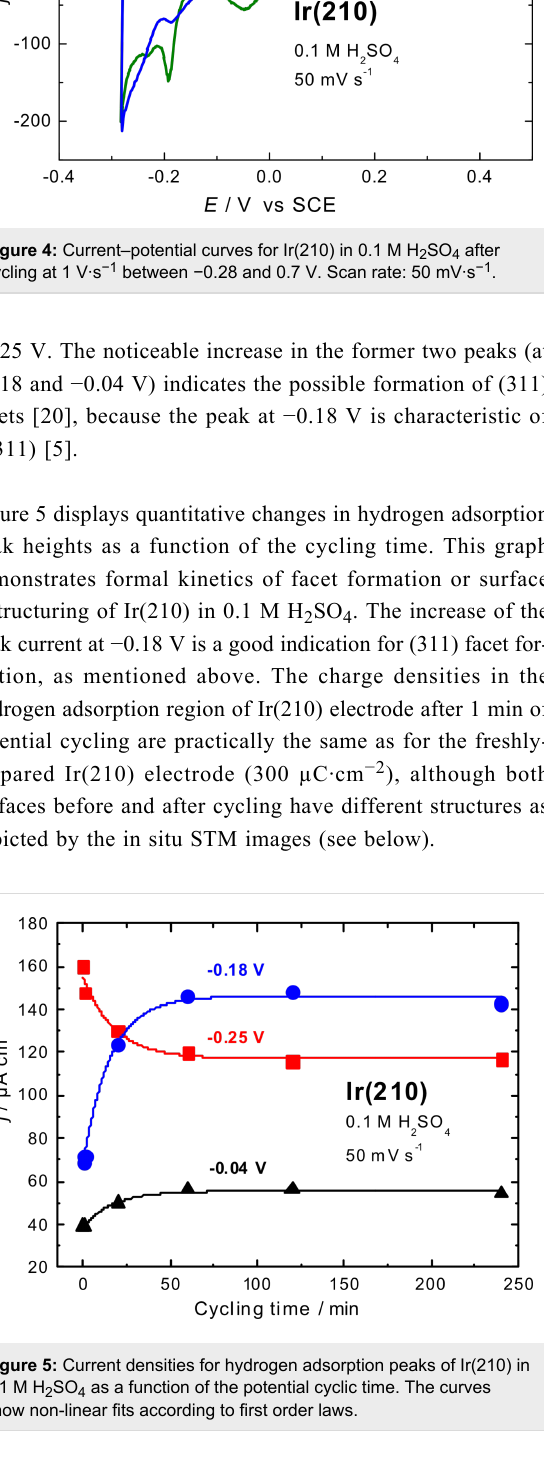
Figure 4: Current–potential curves for Ir(210) in 0.1 M H 2 SO 4 after cycling at 1 V·s − 1 between − 0.28 and 0.7 V. Scan rate: 50 mV·s − 1 .